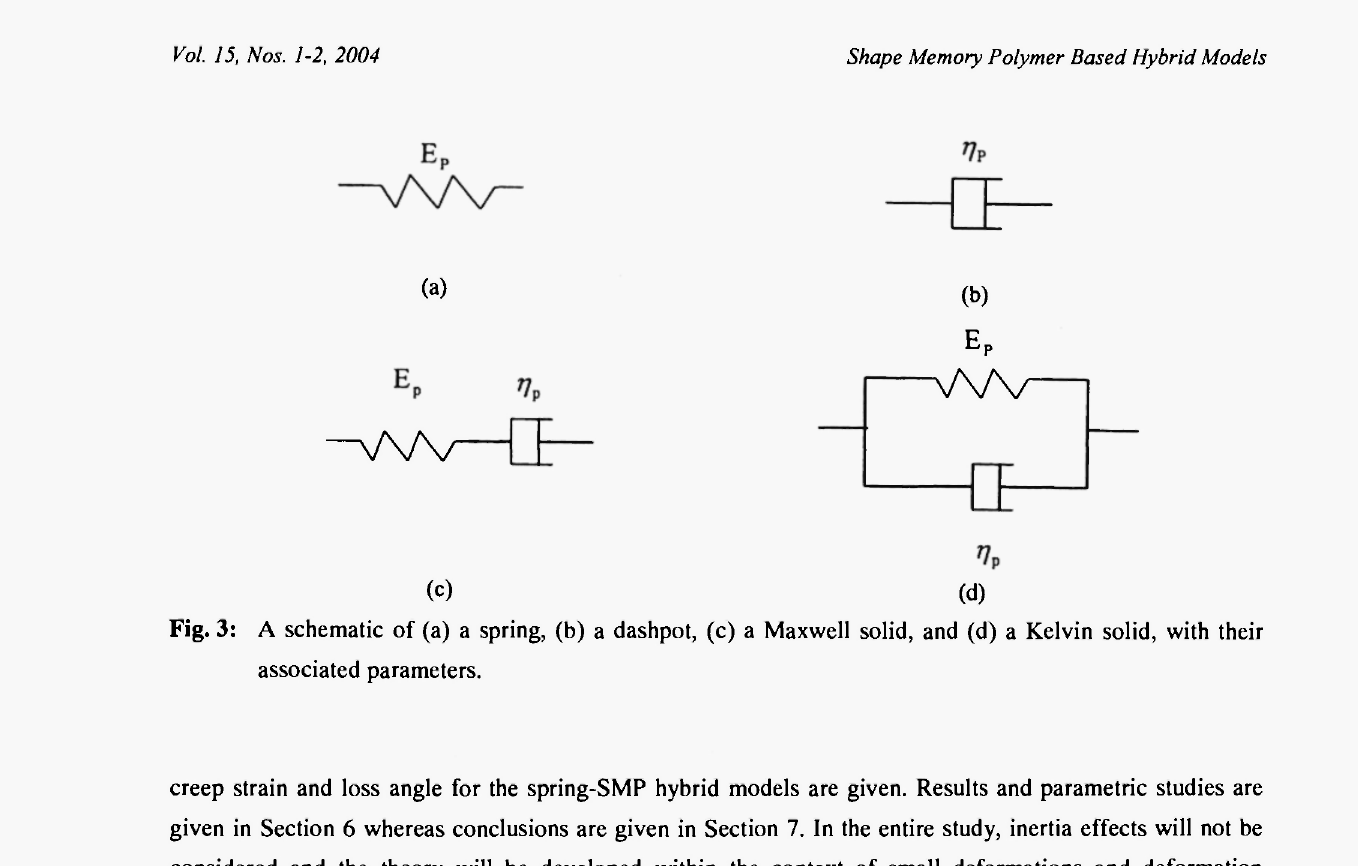
Fig. 3: A schematic of (a) a spring, (b) a dashpot, (c) a Maxwell solid, and (d) a Kelvin solid, with their associated